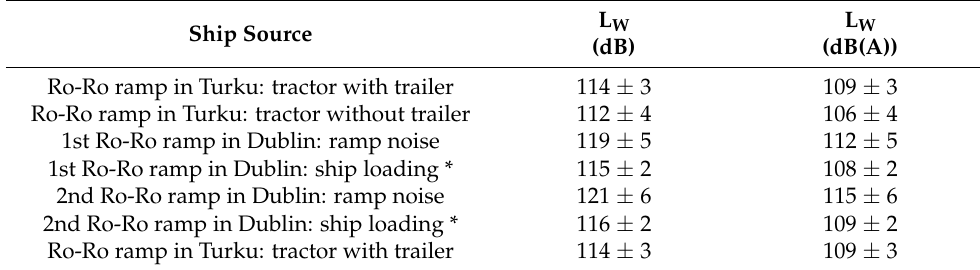
Table 8. Sound power level of Ro-Ro ramps, as reported in deliverable 2.4.3 of [18]. * The ship loading considers the whole measurement period, while other data consider the single event.